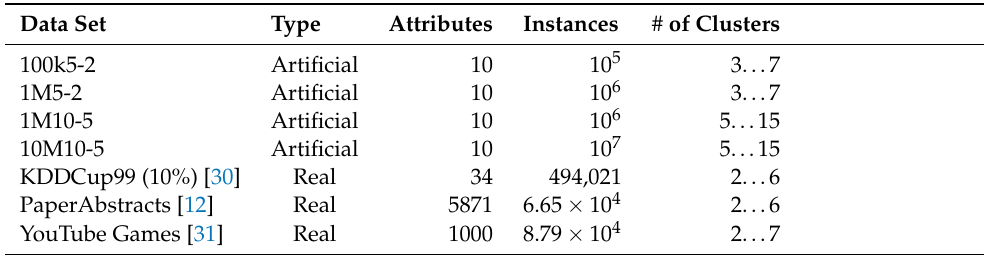
Table 3. Characteristics of artificial and real data sets: the name and type of each data set, their numbers of attributes and instances, and the range of the number of